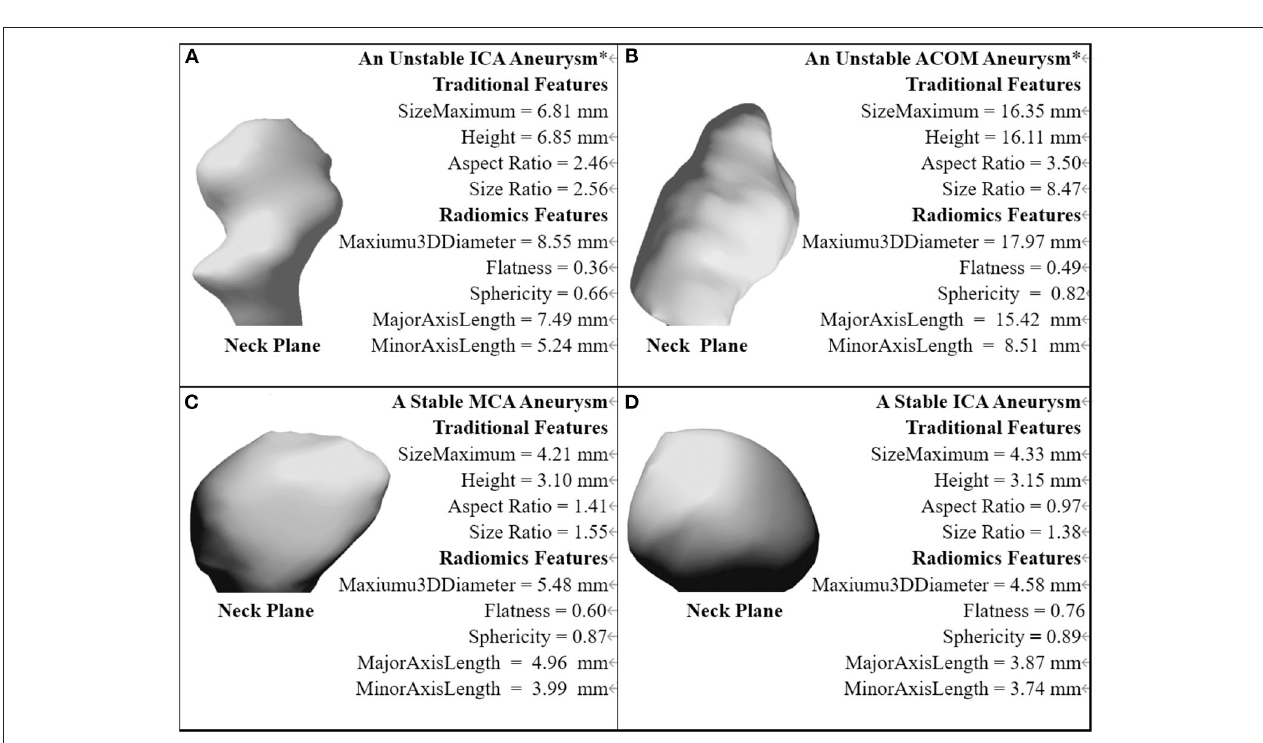
FIGURE 5 | The traditional and Radiomics features of demonstrative cases of four categories. *The aneurysm with a near-term rupture